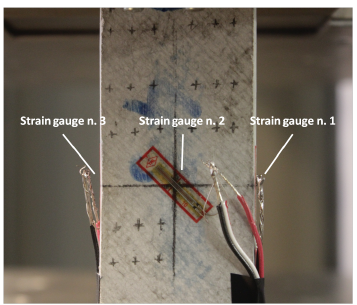
Figure 14: The strain gauges disposition on the 45 ◦ fiber orien- tation sample.